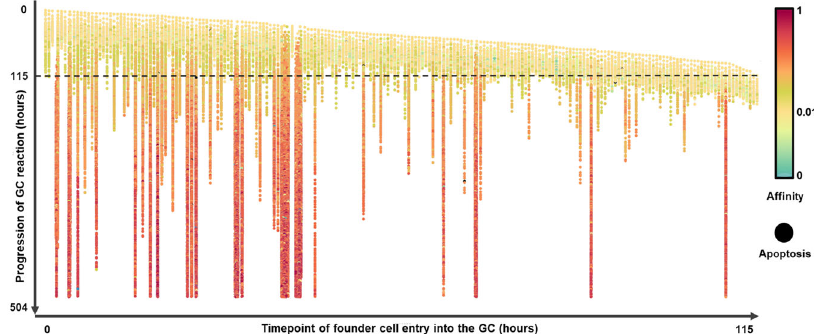
Fig. 6 Lineage trees of all founder cells from one representative simulation. Lineage trees of all founder cells from one representative simulation (Simulation 1; Table 1) ordered by the appearance of the founder cell in the GC ( x axis) and with their daughter cells shown at their time of the appearance in the GC ( y axis). Approximately 200 lineages each derived from founder cells that enter between t = 0 and t = 115 h evolve through the GC reaction. See Supplementary Fig. 8 for an individual B-cell lineage. The x axis shows the timepoints at which the founder cells enter the GC. The y axis shows the evolution of the clones during 21 days (504 h). Colors denote af fi nity of each individual cell. Apoptotic B cells due to lethal mutations in a FWR (non-functional BcR) appear in black. The initial af fi nity of the founder cells is 0.01 (yellow). Each lineage comprises a mixture of GC B cells, MBCs, and PCs. Eighteen clones survived in the GC at day 21, while the other clones have been outcompeted and disappeared from the GC